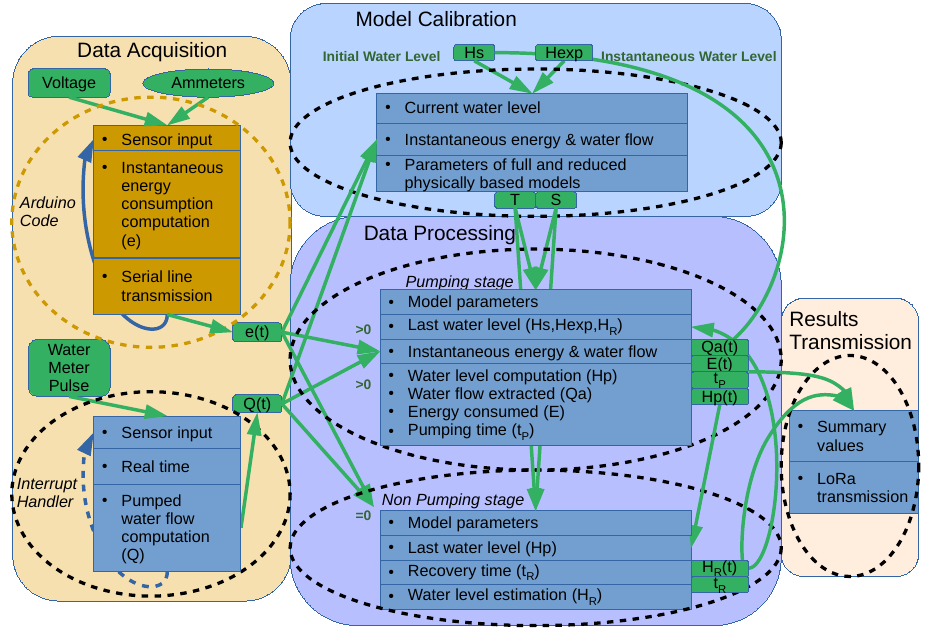
Figure 3. Flowchart block